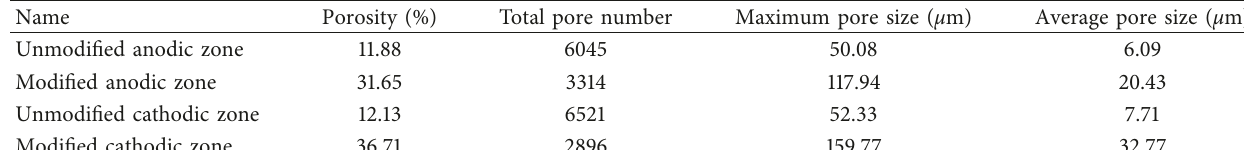
Table 4: Pore structure parameters of anthracite with a diameter of 2.54mm.